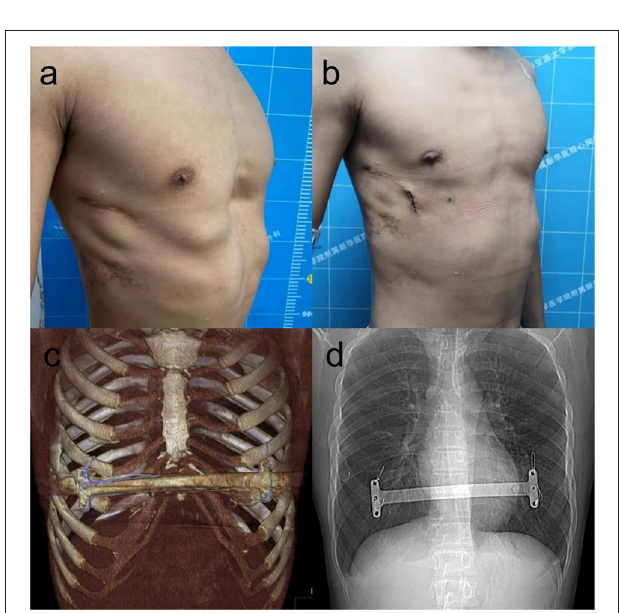
FIGURE 2 | The appearance before (a) and after (b) reoperation of a 22-year-old patient with recurrent pectus excavatum after Nuss procedure. The bar was placed at anterior chest wall (c) , four steel wires fixed bilateral stabilizer of the bar to ensure the stability of the bar (d) .